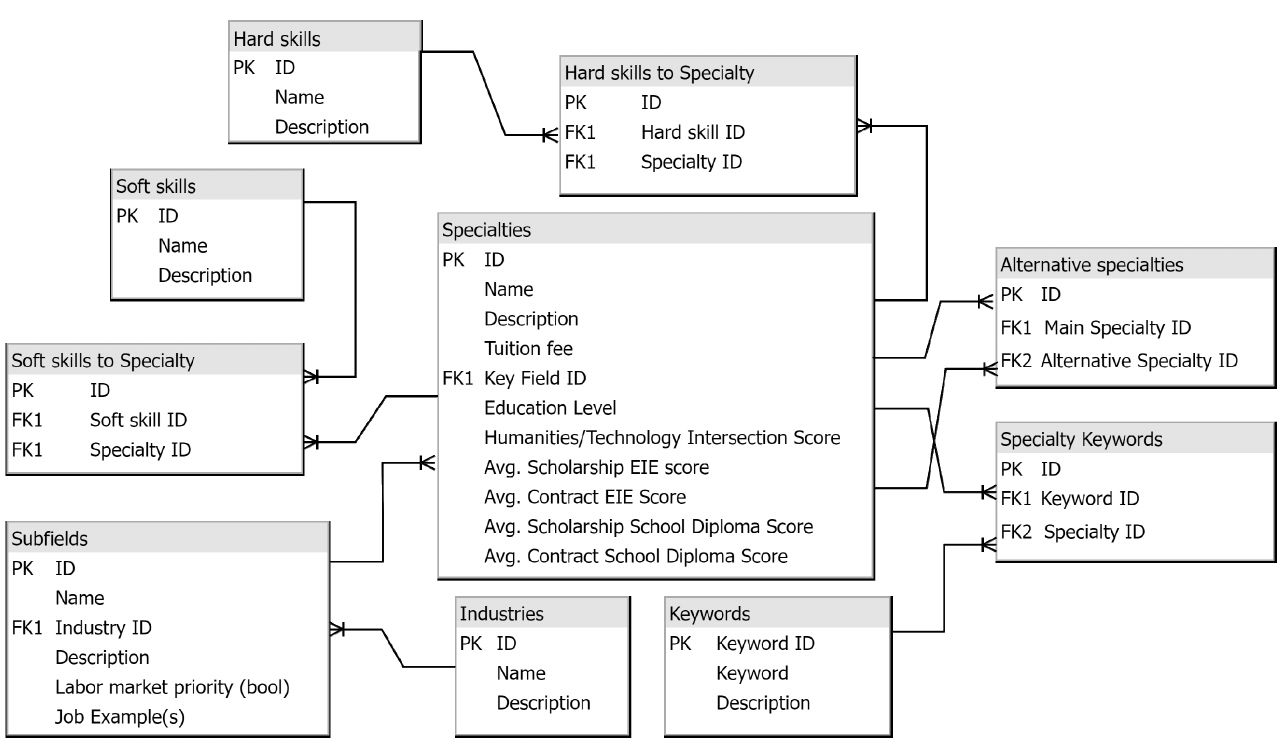
Figure 3. Specialties Database Entity Relationships.